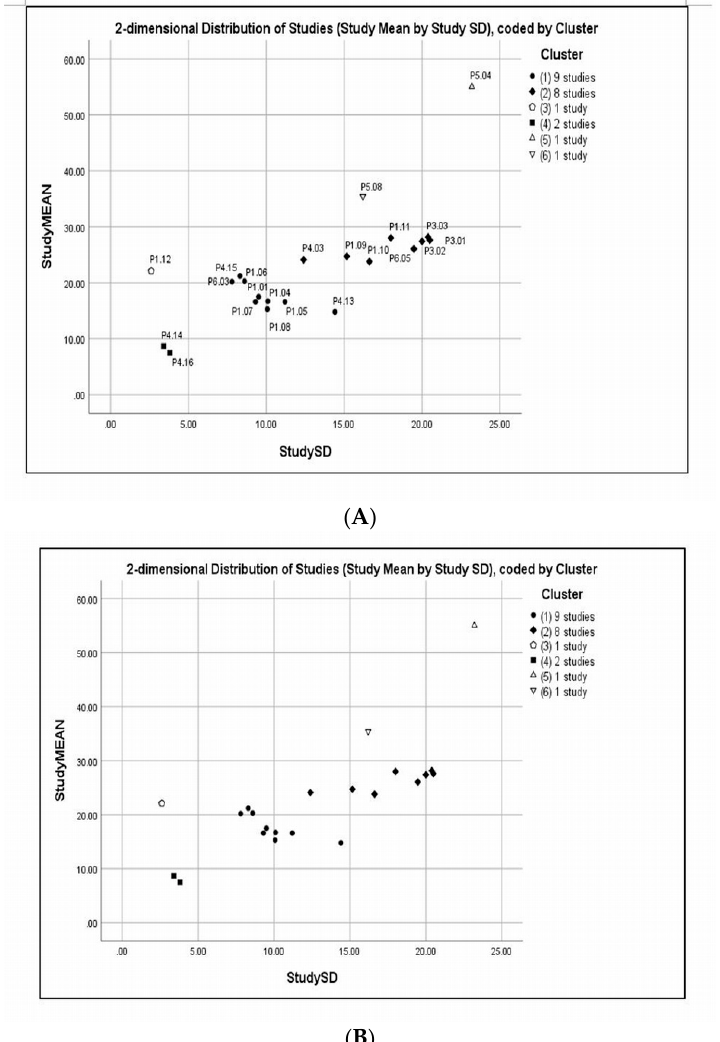
Figure 5. Scatter plot of the study means versus SDs using 6-clusters memberships of the 21 included studies in the subgroup meta-analyses. Legend indicates the number of studies in each cluster, solid fill represents clusters with two or more studies, while open markers represent singleton study. Scatterplot of study means versus SDs with study codes ( A ) and without study codes ( B